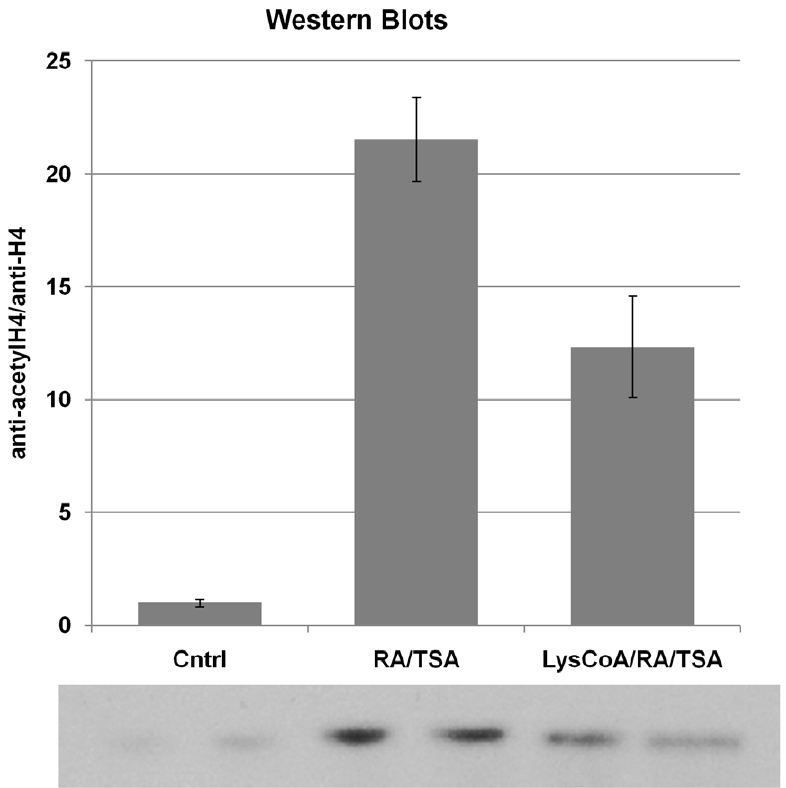
Figure 9. p300 HAT inhibition and trichostatin A. Area-under-the-curve (AUC) pixel densitometry was calculated for scanned, digitized anti- acetyl-histone H4 Western blots (shown at bottom) of A404 cells either untreated (Cntrl), or treated with trichostatin A + retinoic acid (RA/TSA) or trichostatin A + retinoic acid + Lys-CoA-TAT (LysCoA/RA/TSA) for 24 hours. Values shown are a ratio of anti-acetyl-histone H4:anti-histone H4, normalized to untreated control AUC 6 standard error for three experiments. Western lanes (in duplicate) correspond to graph columns.